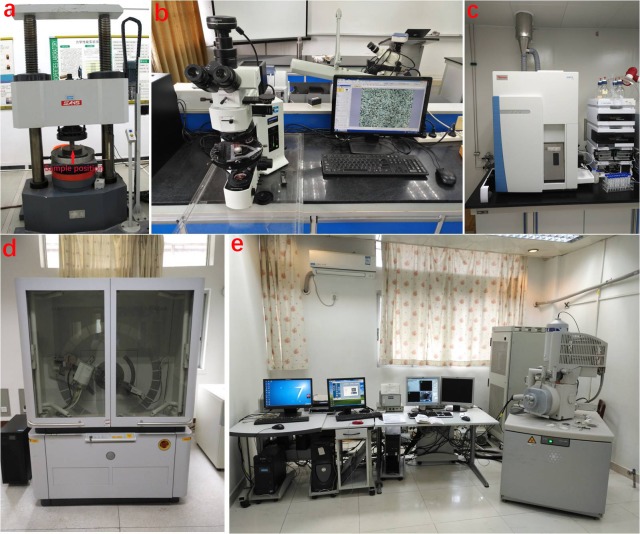
Photographs of main laboratory equipment.(a) The YAW-42061 microcomputer controlled electro-hydraulic servo pressure testing machine. (b) Polarizing microscope (BX51-P). (c) Inductively coupled plasma mass spectrometer (iCAP Qc). (d) PANalytical Empyrean X-ray Diffractometer. (e) Philips Quanta 400 FE Environment Scanning Electron Microscope.